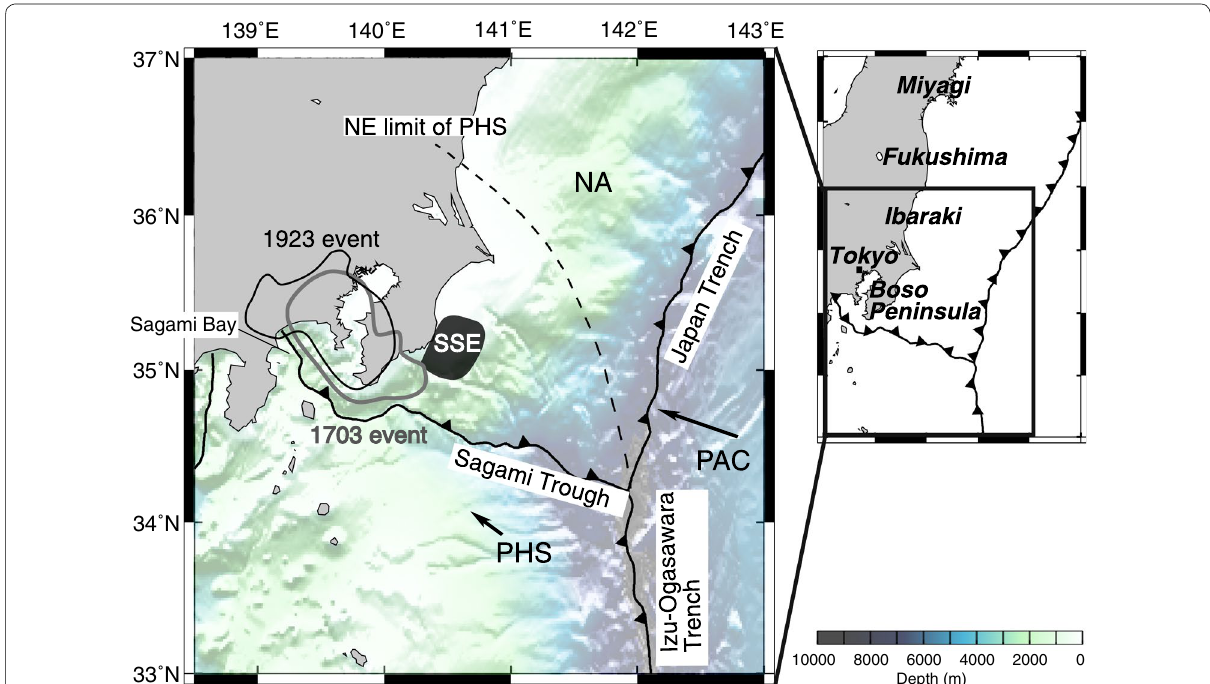
Fig. 1 Tectonic setting and bathymetric map of the study area. The approximate source areas of the 1703 Genroku and 1923 Taisho Kanto earthquakes are indicated by bold gray and thin black lines, respectively, based on Sato et al. (2016) and Matsu’ura et al. (2007). The approximate area of slow slip events is shown in dark gray based on Hirose et al. (2014). The black dashed line denotes the northeastern limit of the PHS reported by Uchida et al. (2009). The black arrows indicate the motion of the PAC and the PHS with respect to the NA (DeMets et al.